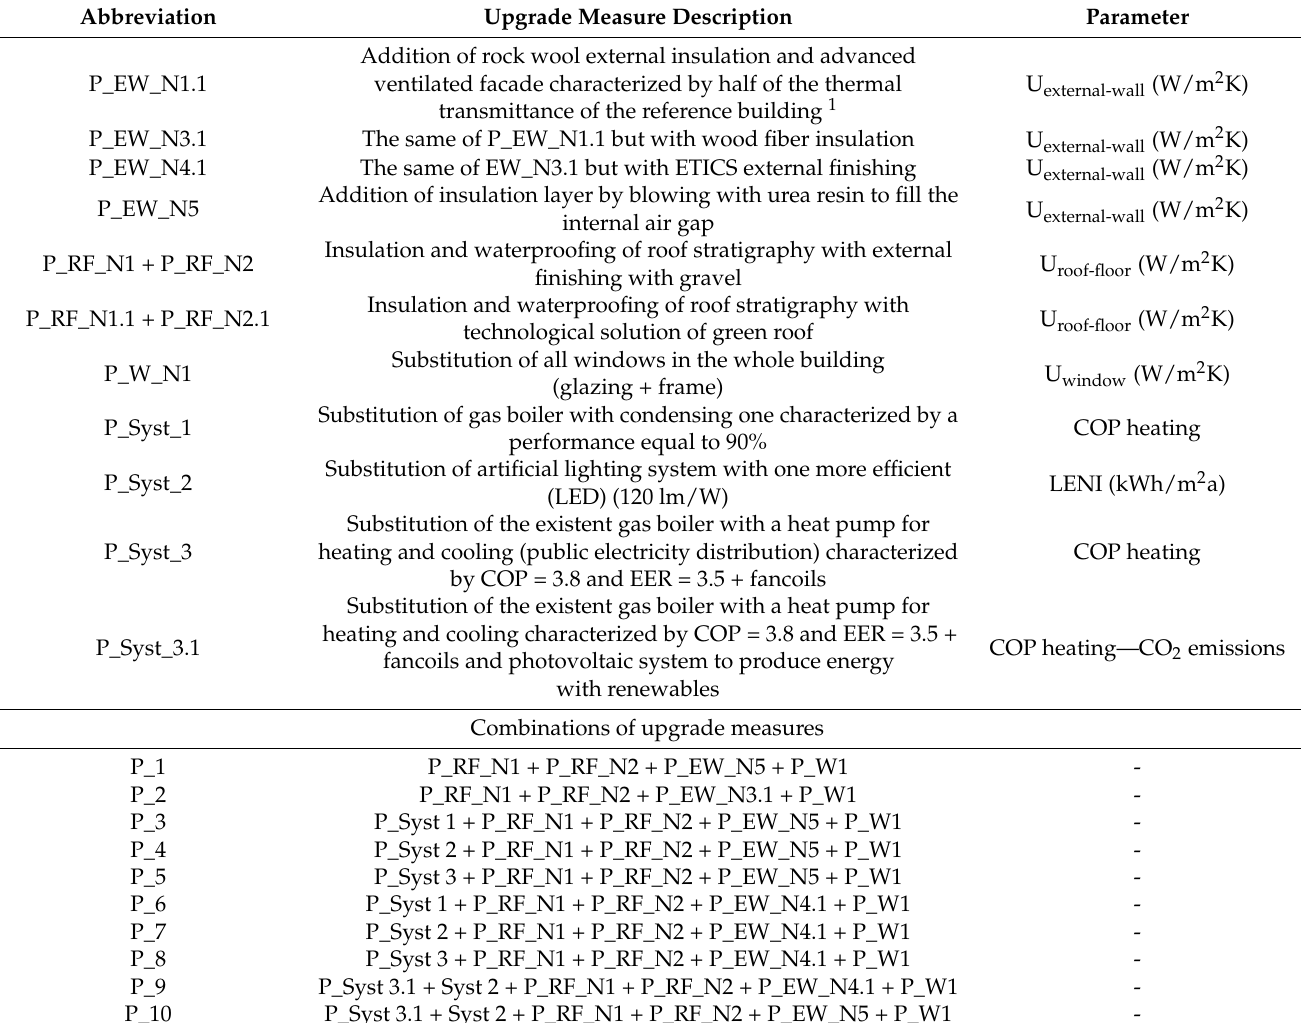
Table 1. Different upgrade measures and their combinations considered in the cost-optimal anal- ysis for Poliziano school. In the table, P stands for Poliziano, EW means external wall, RF roof floor, Syst stands for system, N for new, U means the thermal transmittance, COP means the coeffi- cient of performance, EER stands for energy efficiency ratio, and LENI stands for Lighting Energy Numeric